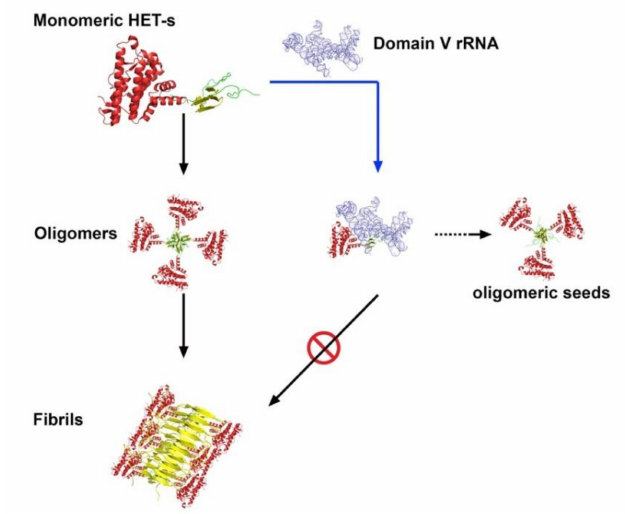
Figure 7. Schematic illustration of the HET-s aggregation pathway and the role of domain V of 23S rRNA. Monomeric HET-s spontaneously undergoes a conformational change to form prefibrillar oligomers, which eventually aggregate to large insoluble amyloid fibrils. However, when it interacts with domain V of 23S rRNA (or other active rRNA components) PFAR prevents misfolding of HET-s and thereby blocks the formation of large, fibrillar (and amorphous) aggregates. Instead, an alternative pathway comes into action and HET-s folds to form soluble “oligomeric seeds” capable of promoting de novo prion